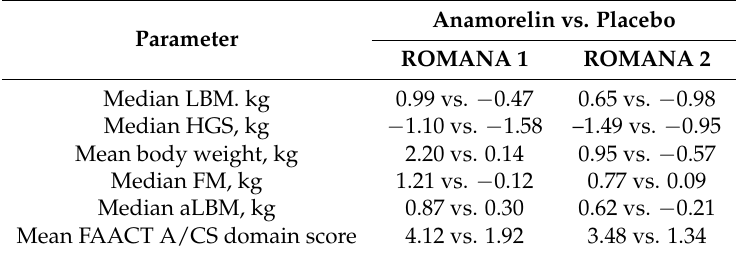
Table 1. Major results of the ROMANA 1 and ROMANA 2